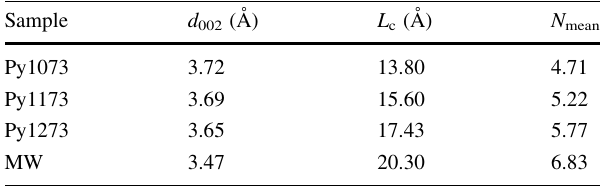
Table 2 Structural parameters of coal and chars